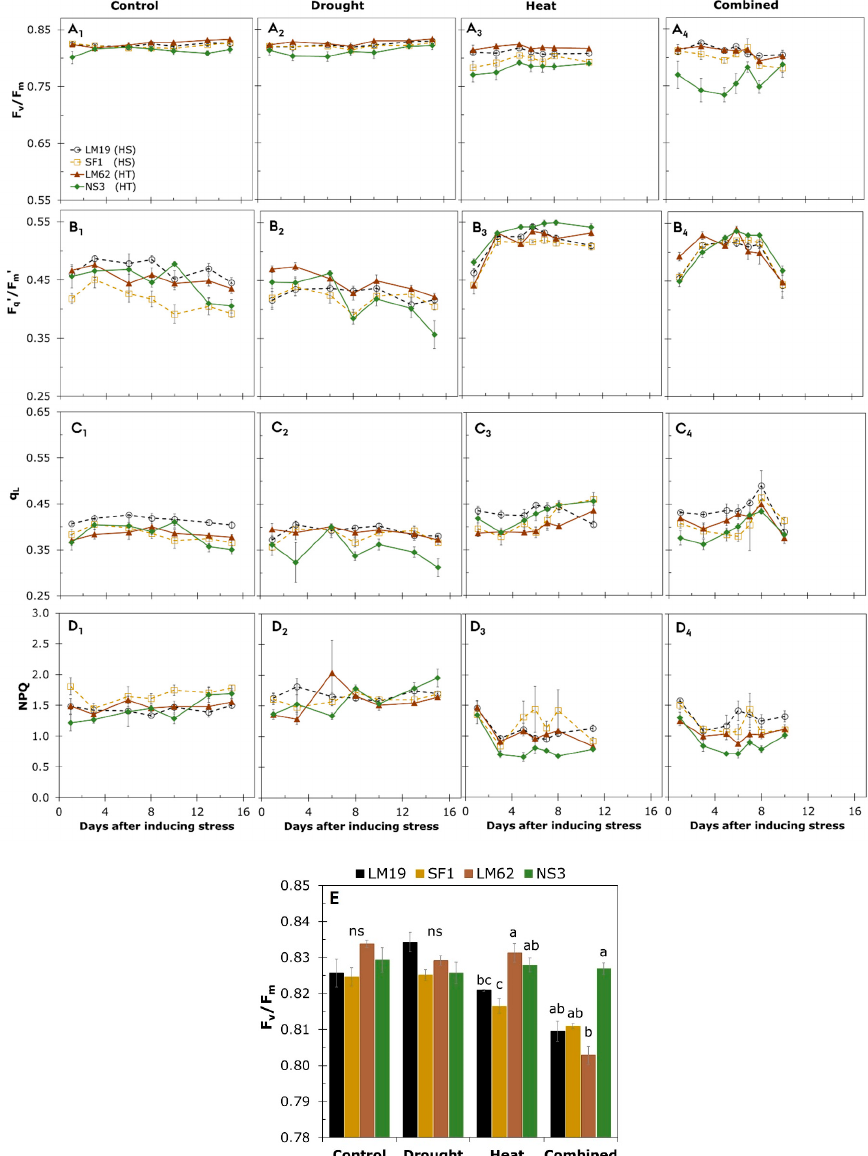
Figure 5. Chlorophyll fluorescence measurements on dark-adapted plants. ( A 1–4 ) Maximum quantum efficiency of PSII photochemistry (F v /F m ). From light response curves at PPFD of 750 μ mol m − 2 s − 1 . ( B 1–4 ) PSII operating efficiency (F q ’/F m ’). ( C 1–4 ) Fraction of open PSII centers (oxidized Q A ) in steady state (q L ). ( D 1–4 ) Non-photochemical quenching (NPQ) at day 1 before inducing the stress and along days after inducing the stress treatments in four wheat genotypes. HS represents heat-sensitive genotypes and HT represents heat-tolerant genotypes. The data represent mean values ± S.E.M. ( n = 4). ( E ) F v /F m measured manually on dark-adapted leaves with FluorPen FP100 at the last day of stress treatments in four wheat genotypes. The data represent mean values ± S.E.M. ( n = 4). Different small letters indicate significant differences in each genotype by using Tukey’s test at level p < 0.05.